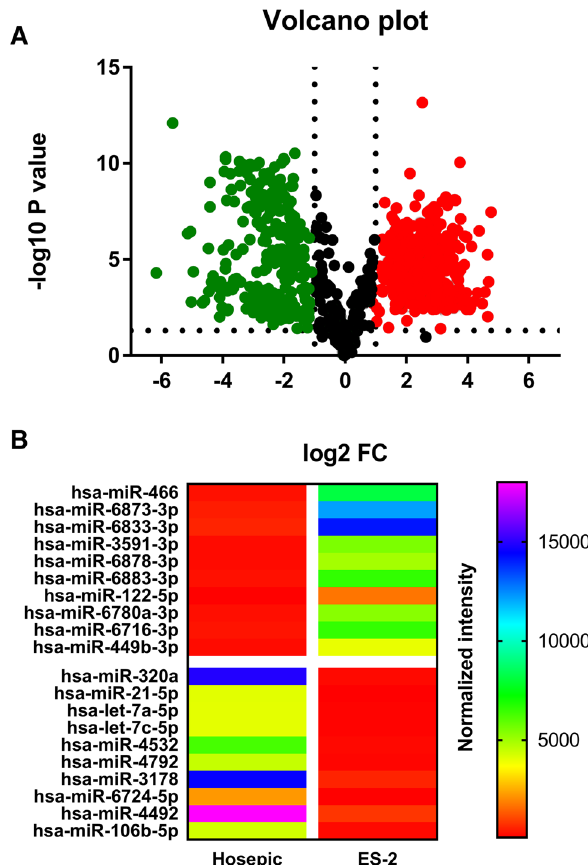
Fig. 3 Identification of differ- ently expressed miRNAs. A Volcano plot of upregulated and downregulated EV- derived miRNAs. B Heatmap of top ten upregulated and downregulated EV-derived